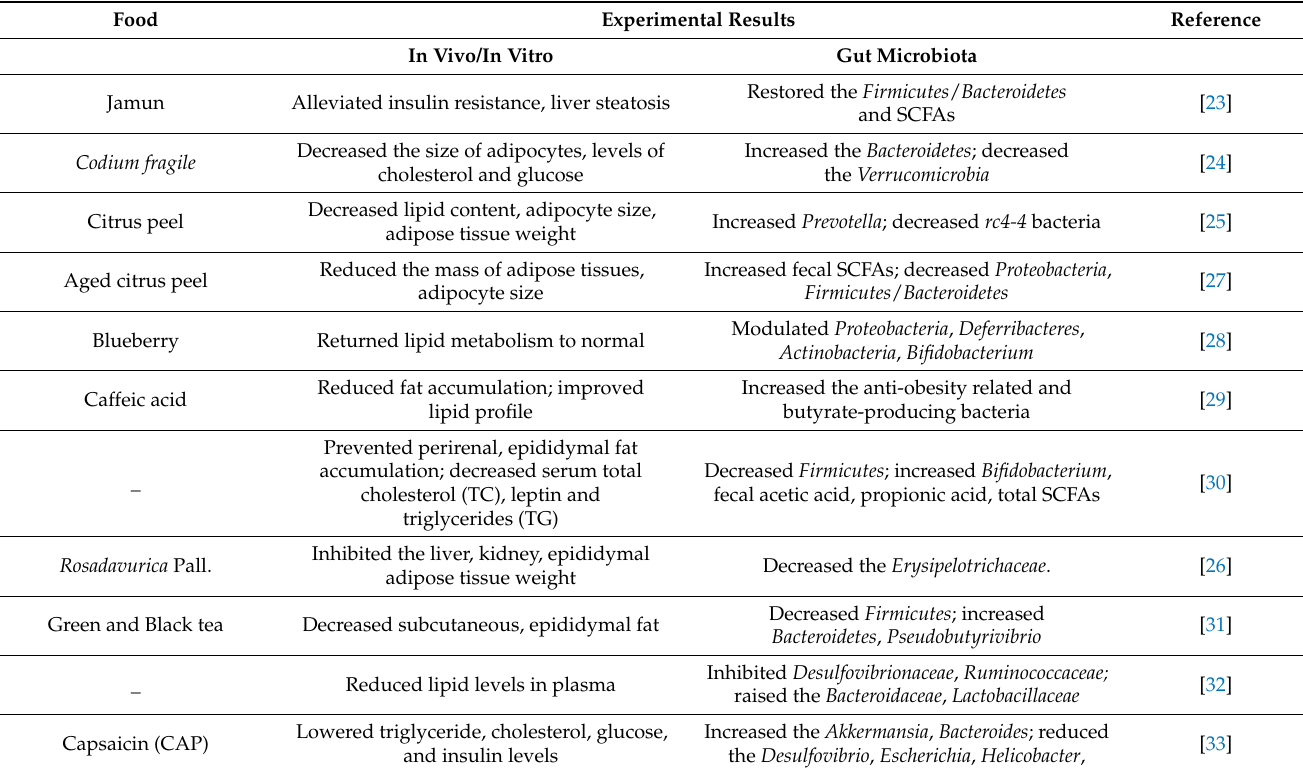
Table 1. Bioactive extract of food against obesity in vitro/in vivo, based on gut